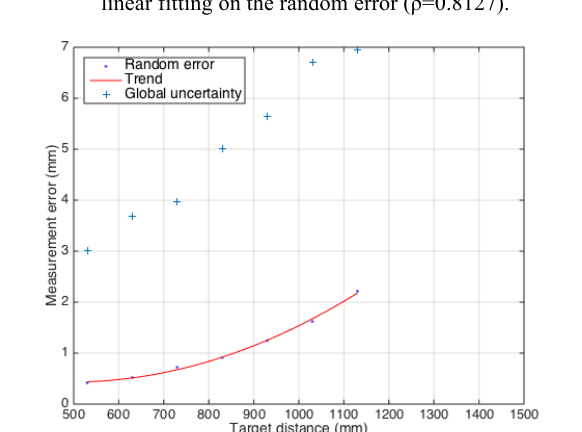
Figure 10. Creative F200 global uncertainty, random error and quadratic fitting on the random error ( ρ =0.9986). The vertical scale covers a larger span respect to the other plots, due to the higher values of